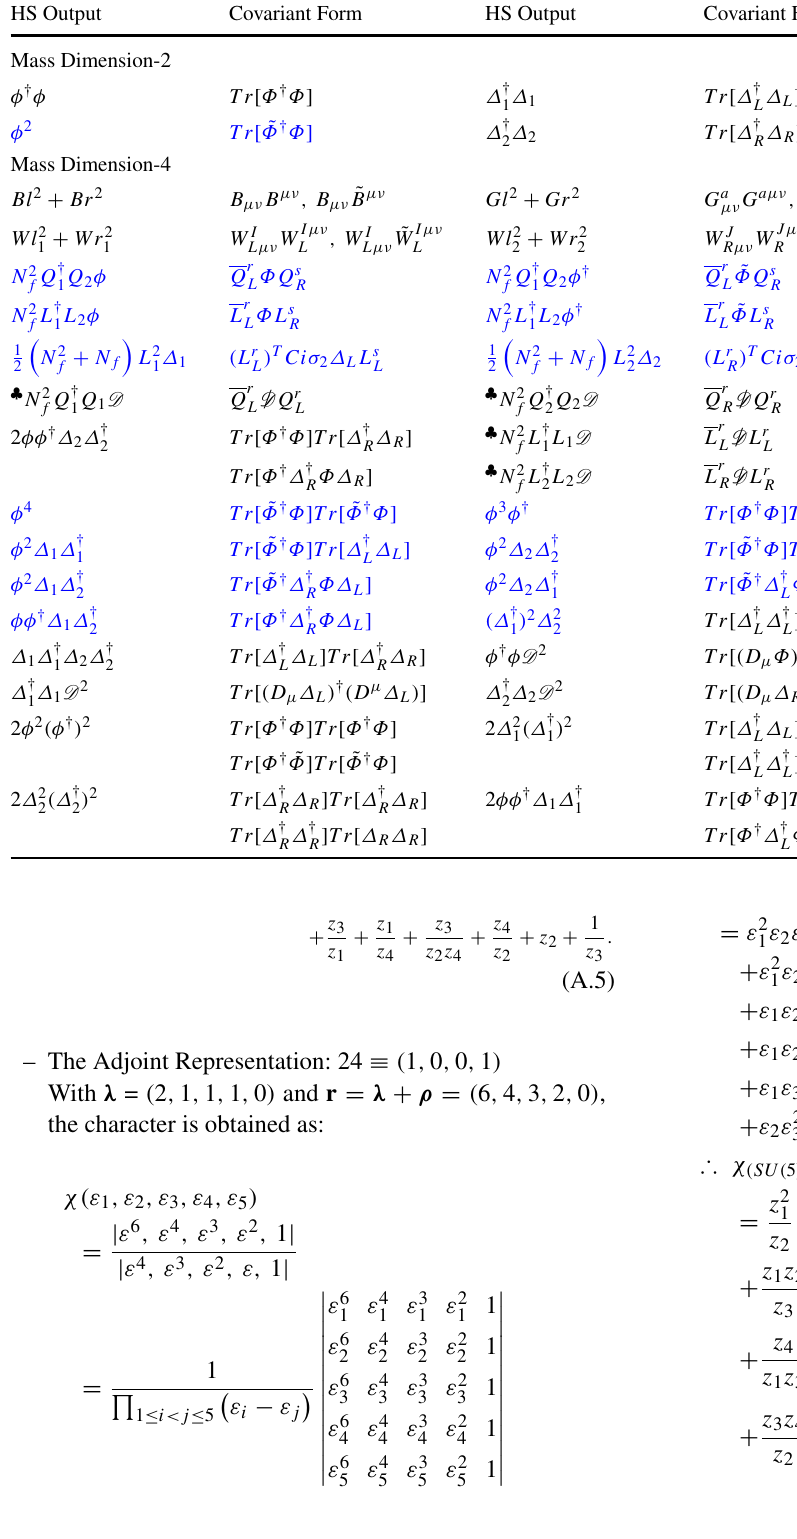
Table 47 MLRSM: Renormalizable operators as Hilbert Series output and their covariant form. The operators in blue have distinct hermitian conjugates which we have not written explicitly. Here, I , J = 1,2,3 are SU ( 2 ) L and SU ( 2 ) R indices respectively; a = 1,...,8 are SU ( 3 ) indices and r , s = 1 , 2 ,..., N f are flavour indices which are summed over with the suitable coupling constants. ♣ - In the Hilbert Series the fermion HS Output Covariant Form HS Output Covariant Form No. of Operators (including